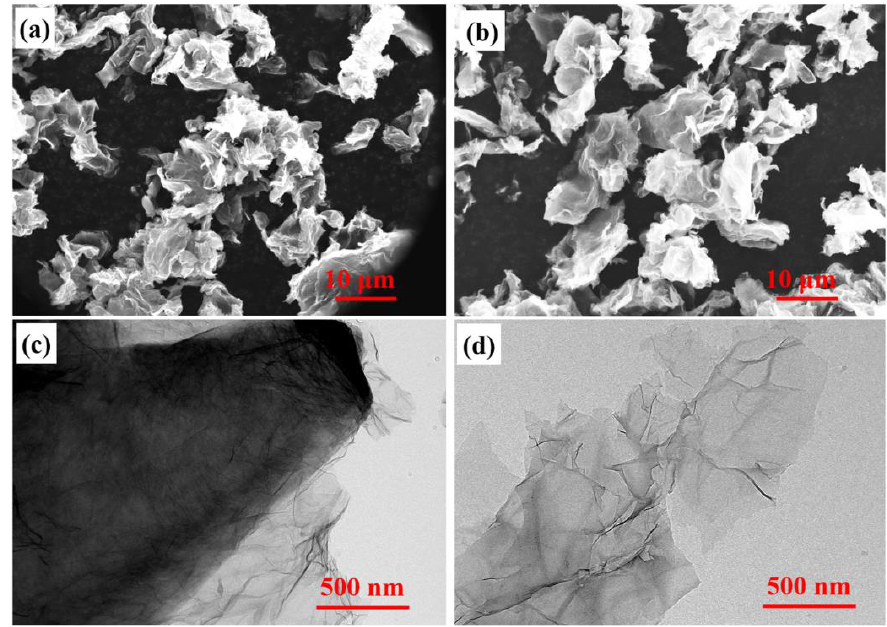
Figure 3. The SEM and TEM images for G and DA@G powder: ( a ) and ( c ) for G and ( b ) and ( d ) for